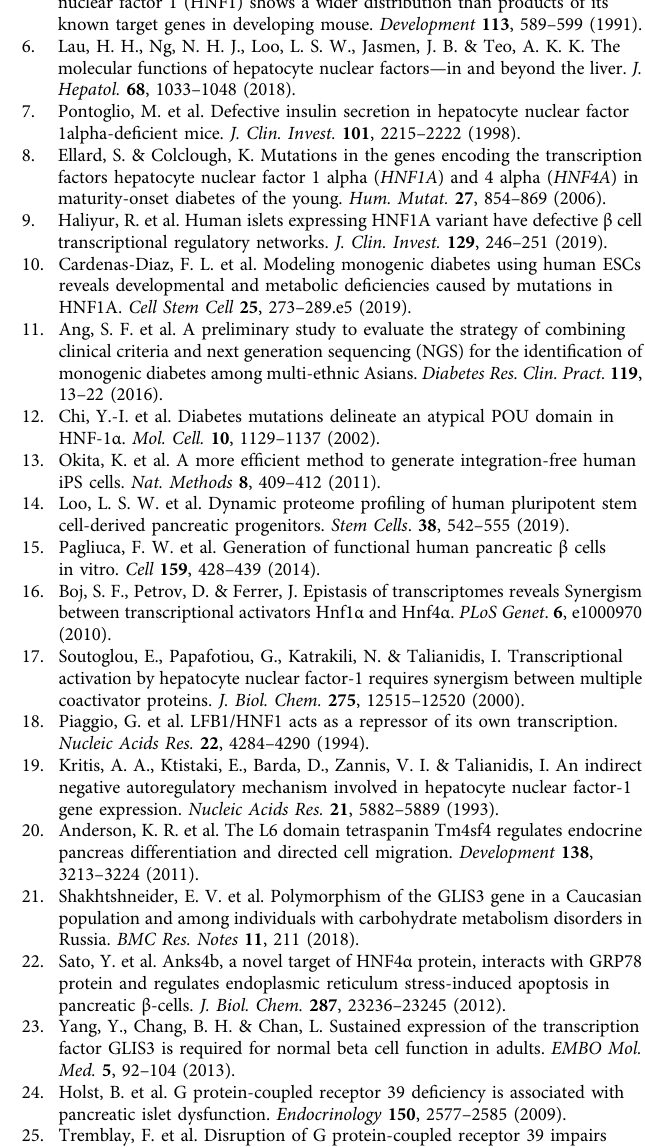
Fig. 8 HNF1A H126D mutation reduced the ability of HNF1A to upregulate GLUT2 gene expression. a RT-qPCR analysis of GLUT2 , GLUT1 and GLUT3 transcripts in AD-293 cells overexpressed with GFP (green) and various WT (red), H126D (blue) and P291fsinsC (purple) HNF1A constructs. n =